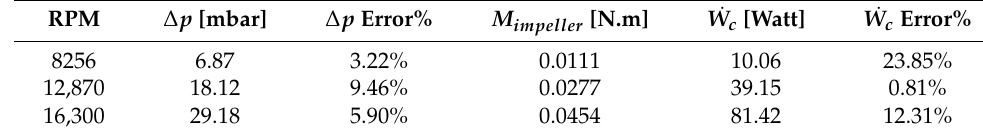
Table 7. TBP numerical model comparison with different experimental points.